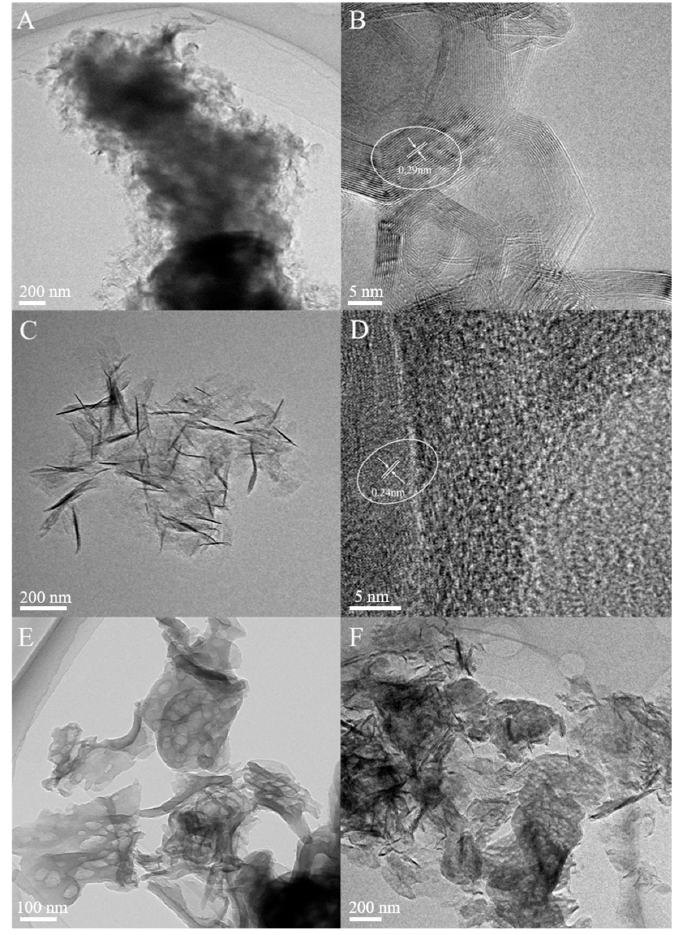
Figure 3. TEM images of ( A and B ) Al 2 O 3 , ( C and D ) Cu/Al 2 O 3 , ( E ) CN, and ( F ) Cu/Al 2 O 3 /CN.